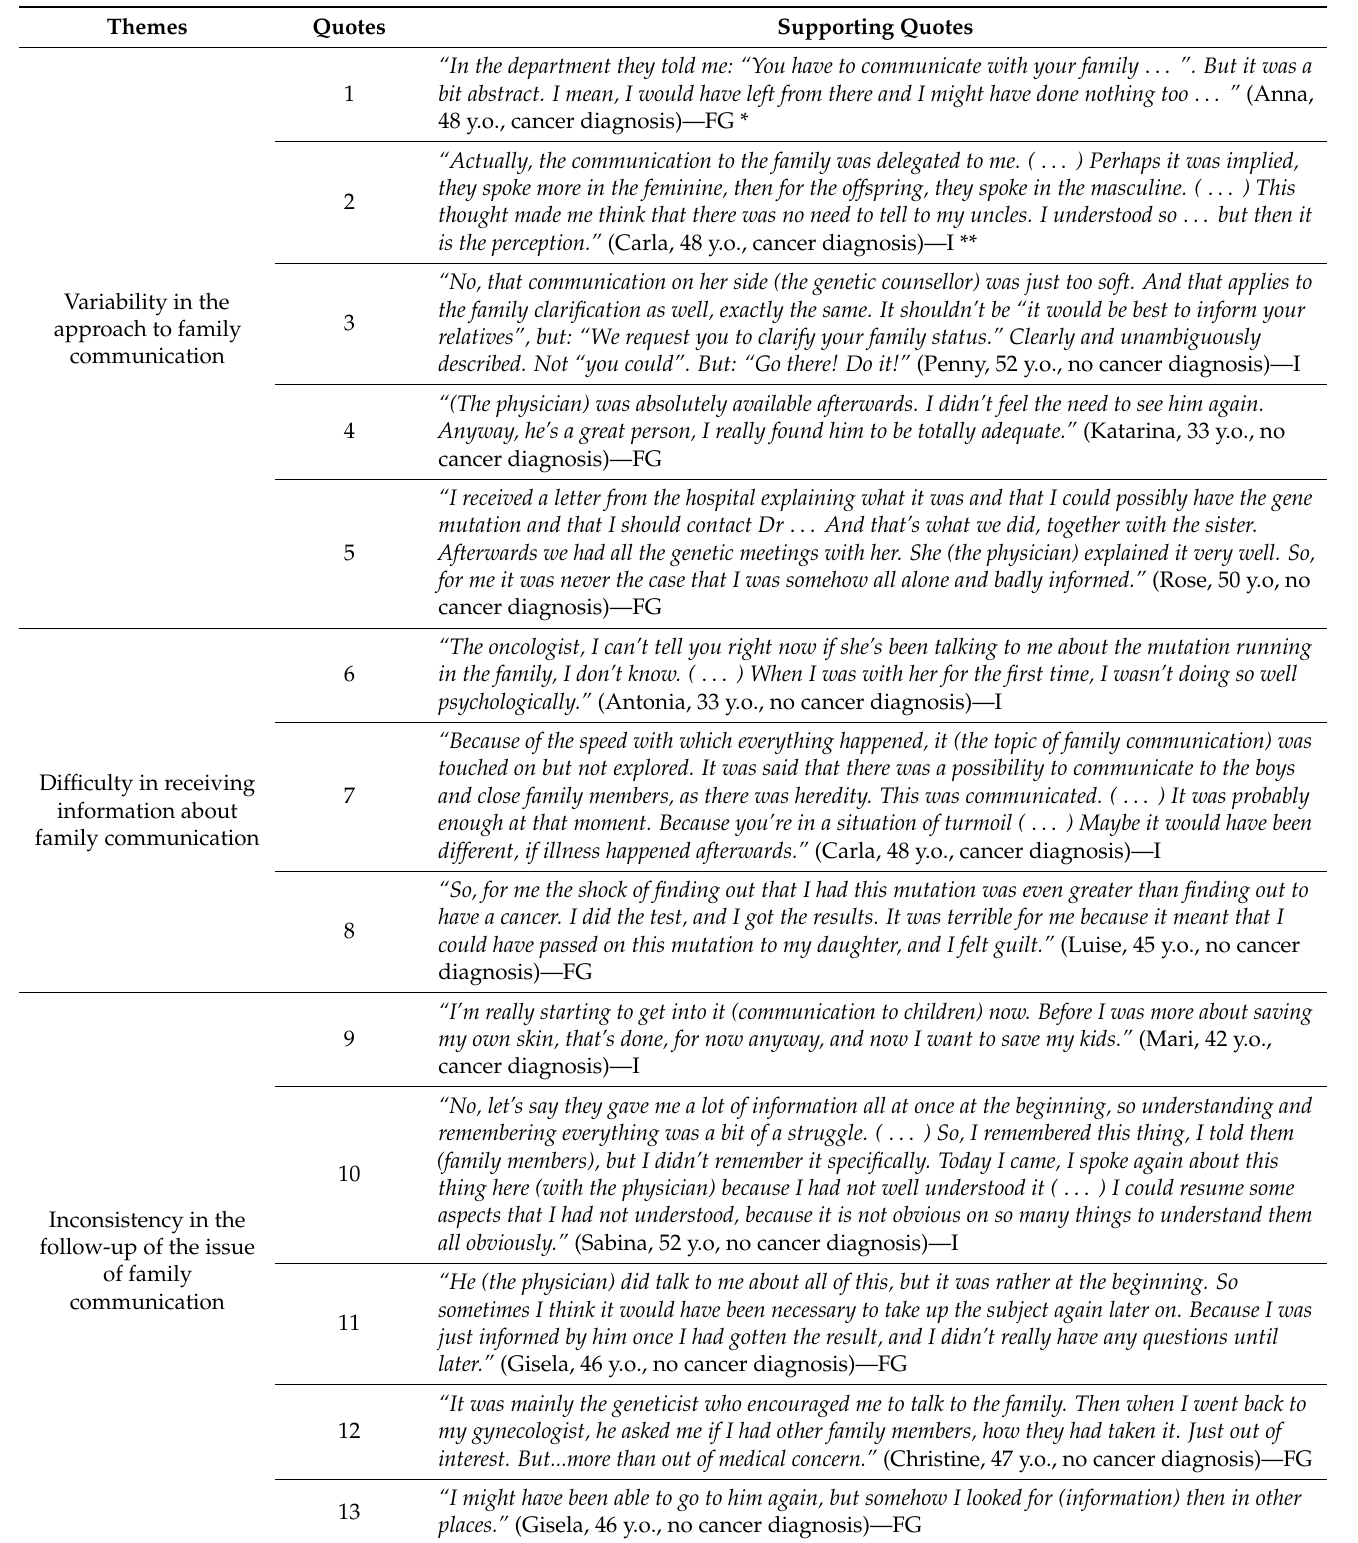
Table 2. Supporting quotes about “Communication between healthcare providers and